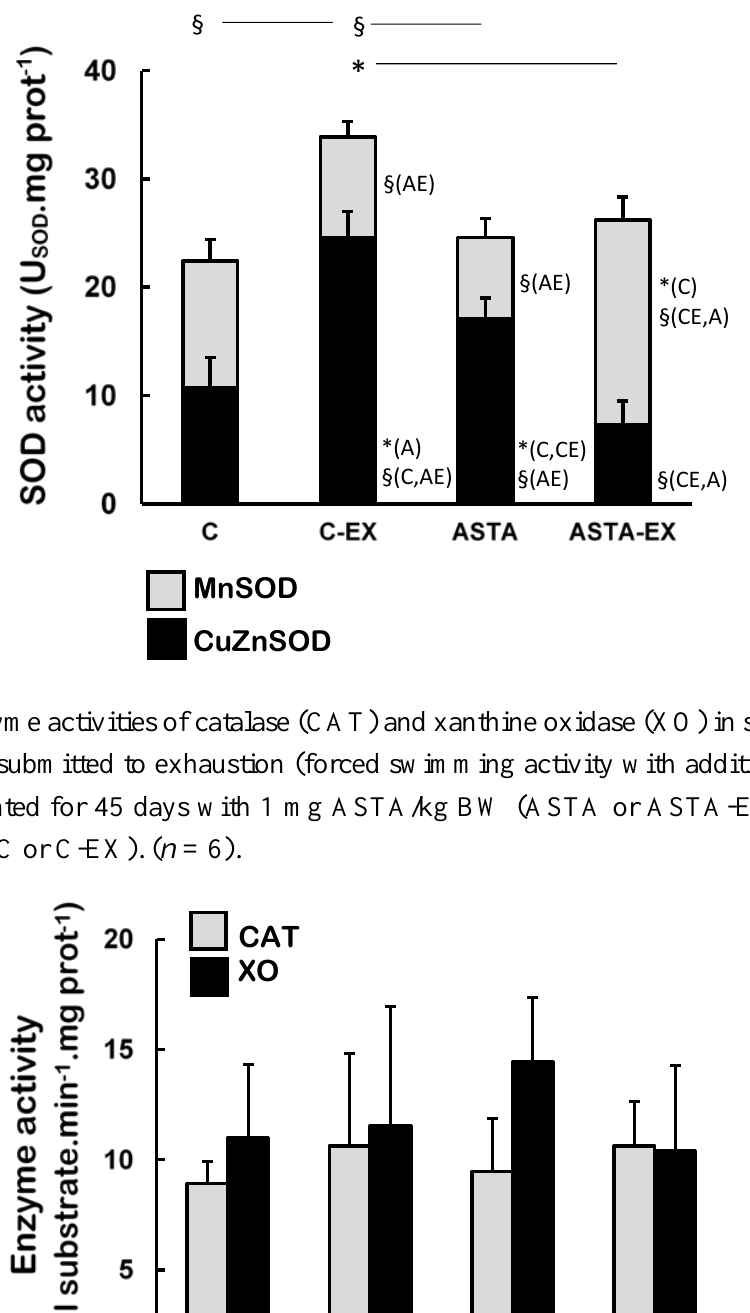
Figure 3. Enzyme activities of total-, CuZn- (cytosolic), and Mn-dependent (mitochondrial) SOD in soleus muscles of Wistar rats submitted to exhaustion (forced swimming activity with additional 5% BW) and supplemented for 45 days with 1 mg ASTA/kg BW (ASTA or ASTA-EX) or mineral oil as control (C or C-EX) ( n = 6) * ( p < 0.05); § ( p < 0.005), compared to: control (C), control exhausted (CE), ASTA-fed (A), or ASTA-fed exhausted (AE).